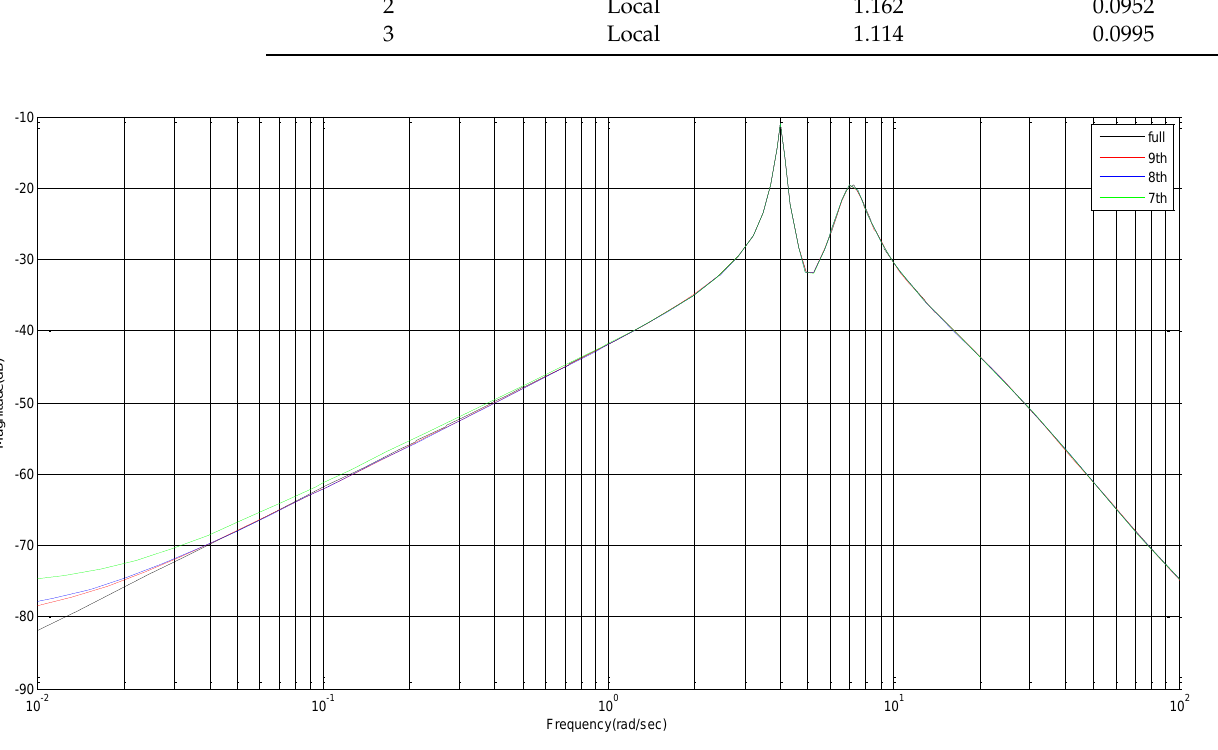
Figure 3. The response of frequency for system with 76–order, 9–order and 8-order. For the following given numbers, θ 1 = θ 3 = θ 5 = θ 7 = ε 2 = ε 4 = ε 6 = ε 8 = 1, θ 2 = θ 8 = ε 3 = ε 5 = − 1, θ 4 = θ 6 = ε 1 = ε 7 = 0, the parameters of the controller are obtained according to Theorem 2 by virtue of the LMI toolbox in MATLAB.